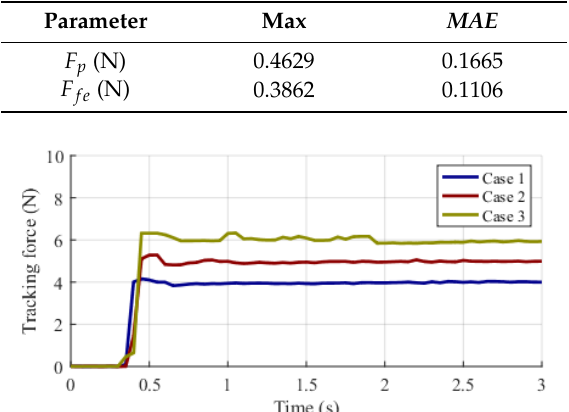
Table 4. The quality parameters on the testing data of the experiment.